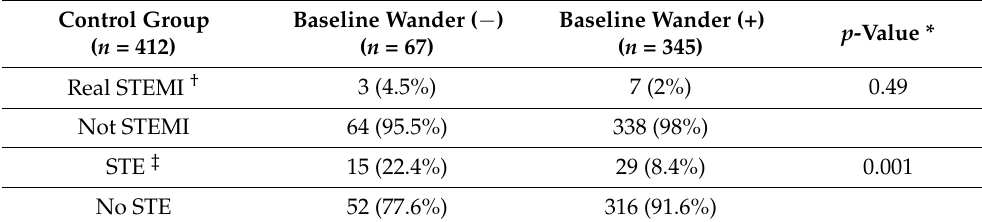
Table 3. Analysis of false positive cases to measure the effect of baseline wander on the accuracy of deep learning model. Control Group Baseline Wander ( − ) ( n = 412) ( n =